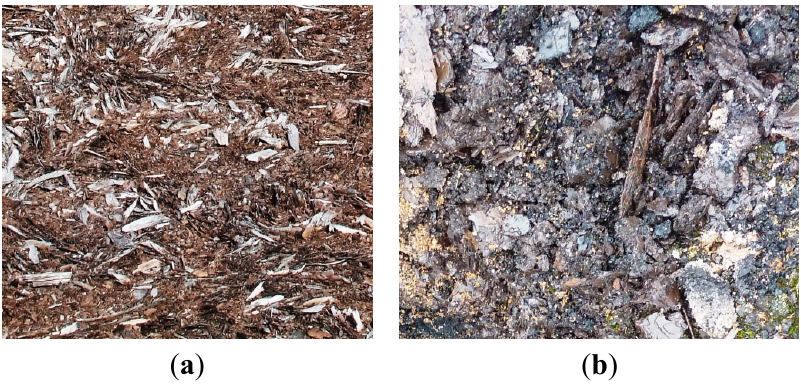
Figure 1. Bark samples from ( a ) site A (Köpmannebro); and ( b ) site B (Österbybruk).